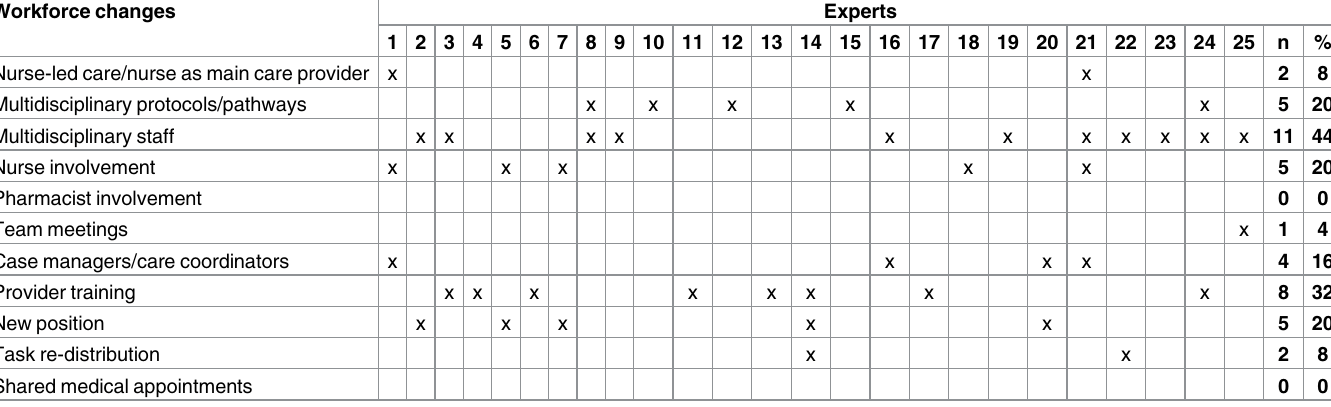
Table 4. Overview of the workforce changes described by the questionnaire respondents and number and percentage of respondents mentioning the respective changes. Workforce